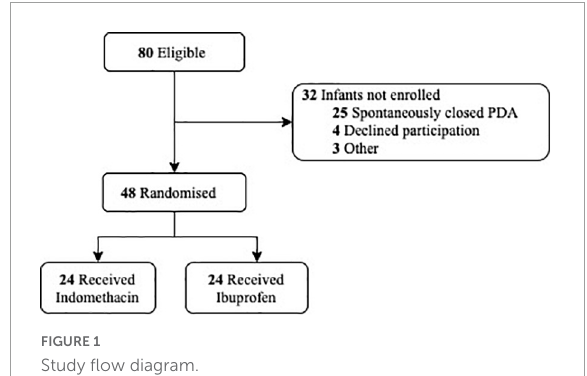
FIGURE1 Study flow